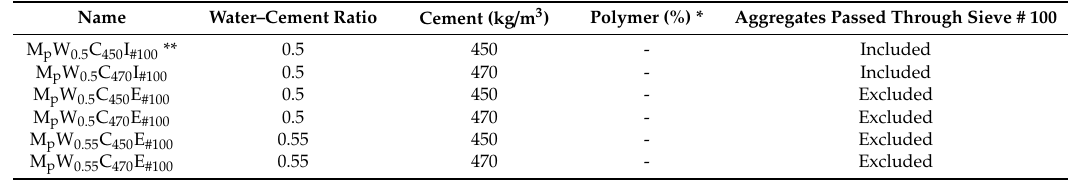
Table 4. Details of mix designs in the primary